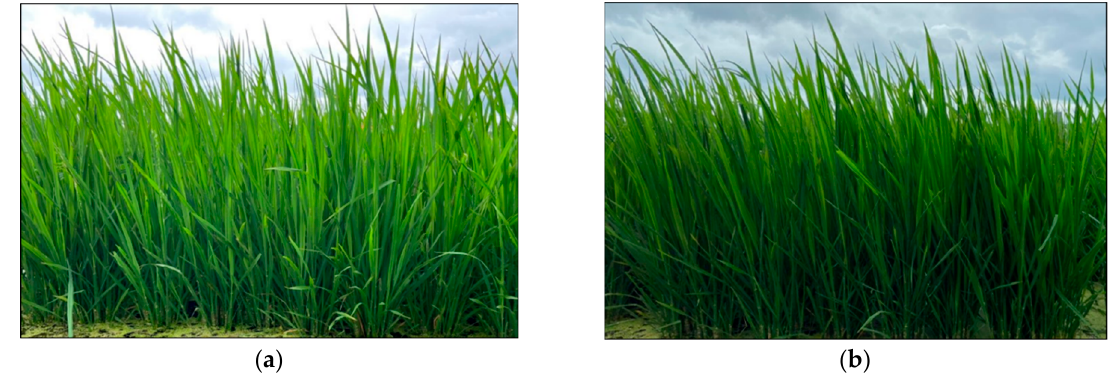
Figure 1. The two forage rice cultivars during the heading stage: ( a ) Mogwoo; ( b ) Mogyang.